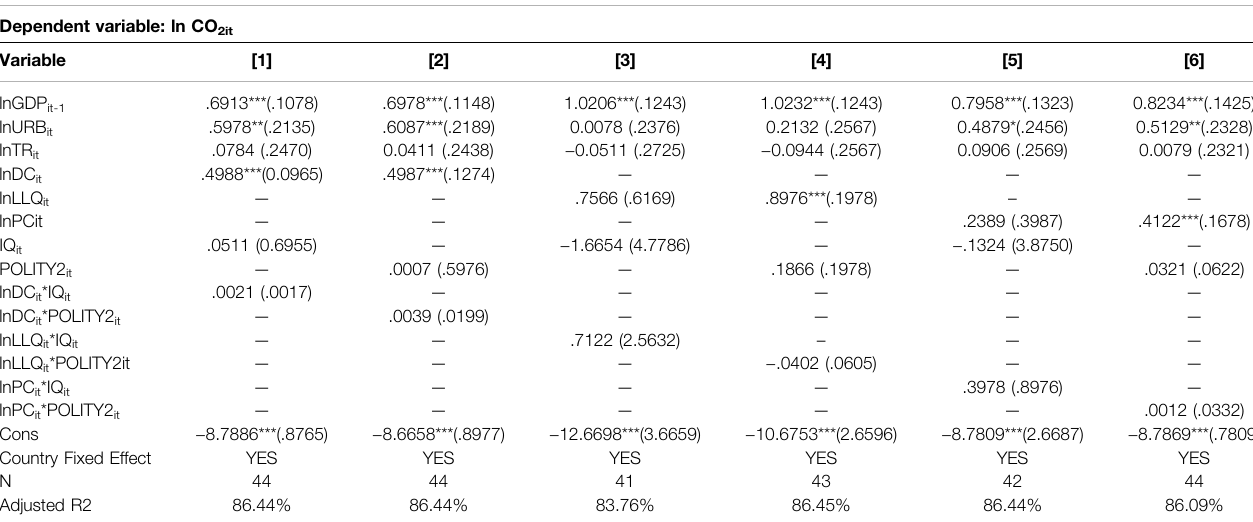
TABLE 5 | Environment kuznets curve